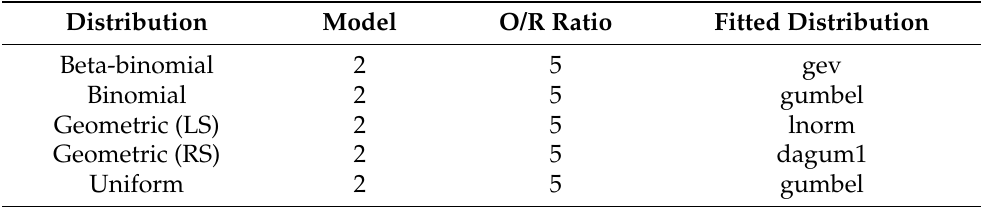
Table 2. The most representative fitted distributions for each initial rod length distribution evaluated by employing a linear weighting scheme on the top five fitted distributions for all four central zones and for the entire structure, as presented in Table